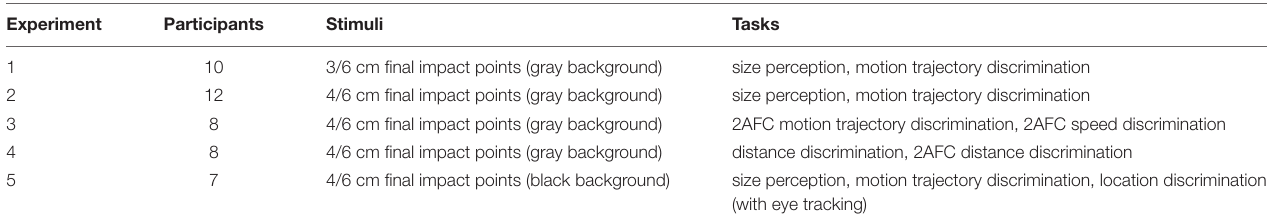
TABLE 1 | Summarized experimental